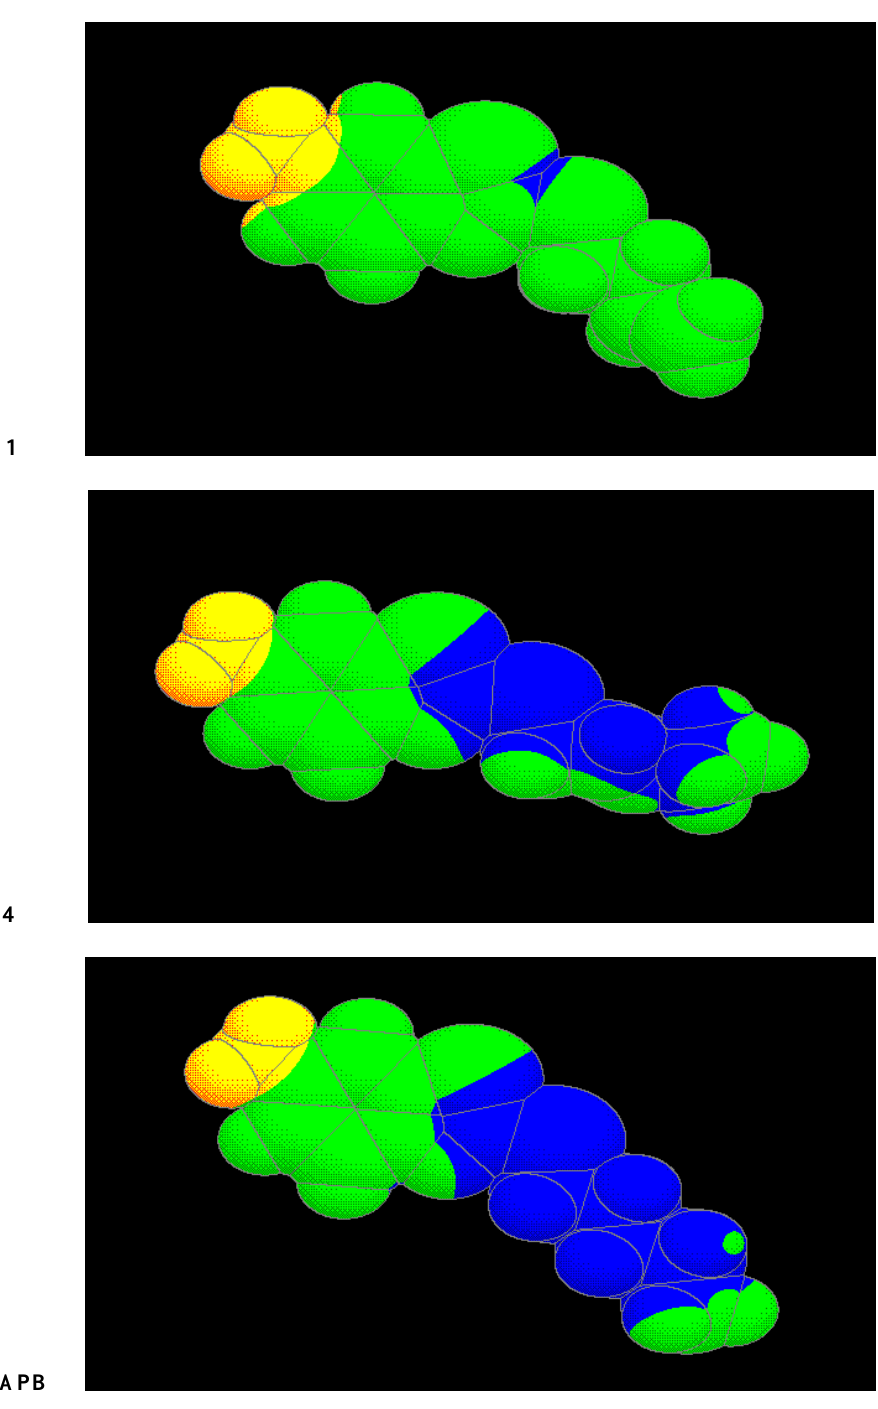
Figure 1. Distribution of lipophilicity on the Van der Waals surface (the highest value of the lipophilicity is in the blue color